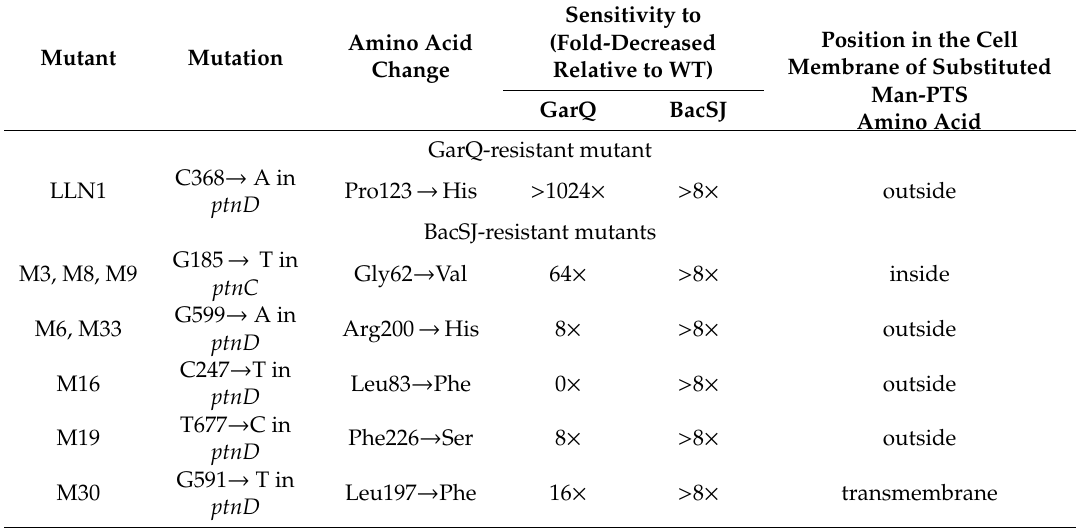
Table 2. Amino acid substitutions in Man-PTS from L. lactis IL1403 mutants resistant to BacSJ.